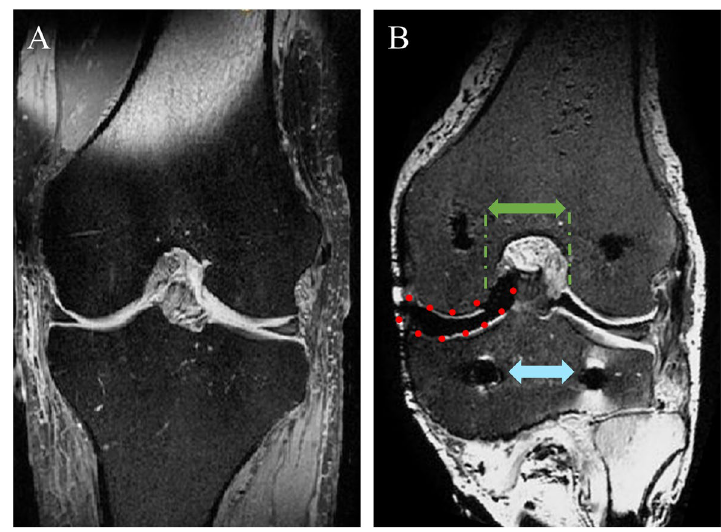
Fig. 1 MRI scans in the frontal view (A–P): A ) intact left knee joint and B ) resected, with capsuloligamentous structures intact in the left knee joint (white tissue capsule), applied notchplasty (green arrow) with muscle insertion sites (blue arrow, hamstring muscles) and device left in place (red dashed line, black shadow)